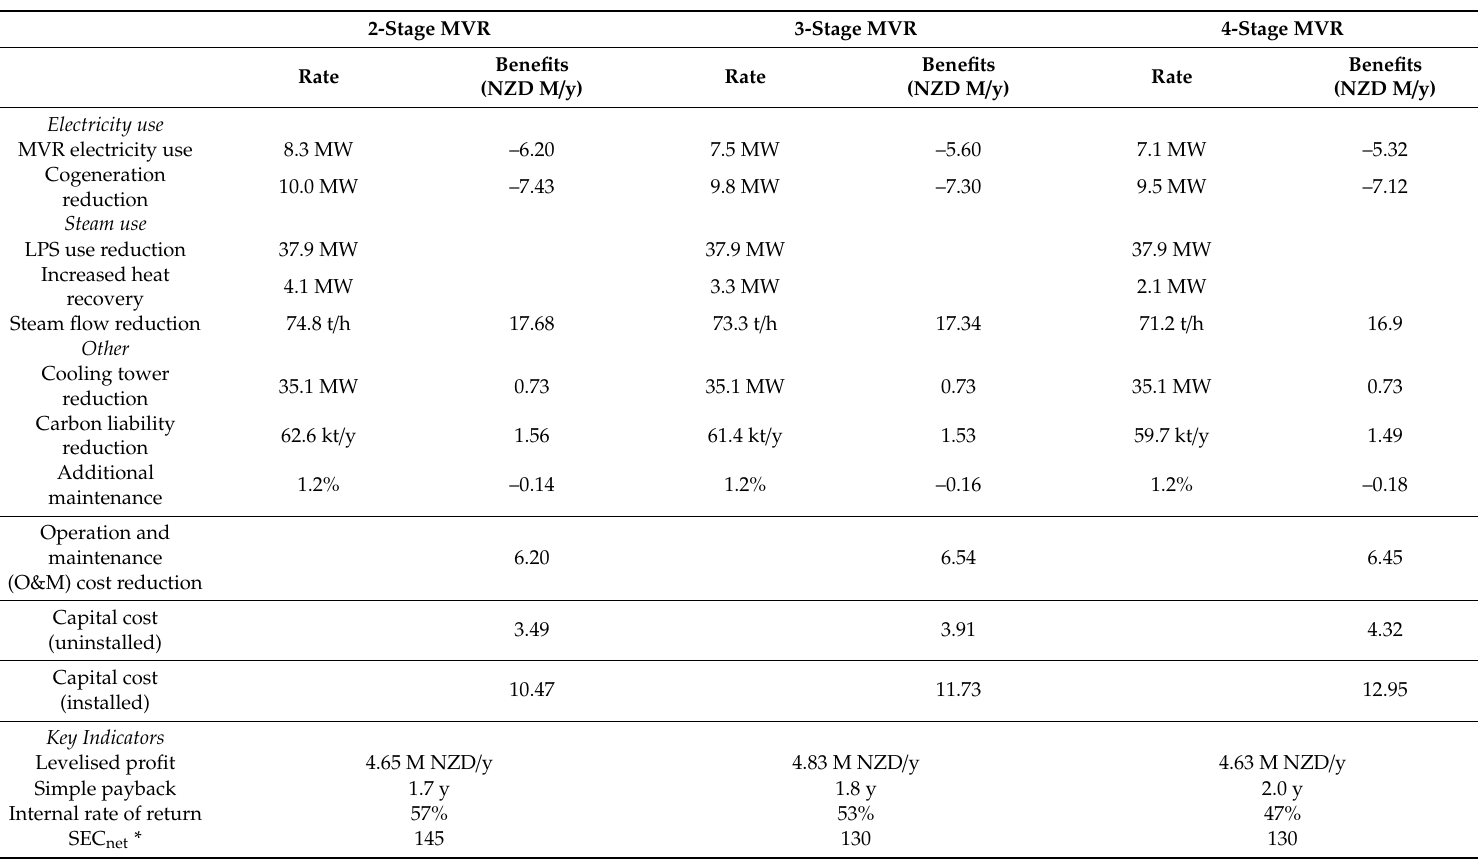
Table 7. Thermo-economic assessment of retrofitting various multi-stage mechanical vapour recompression options with an existing e ff ect evaporator. The assessment is compared to the conventional 7-e ff ect